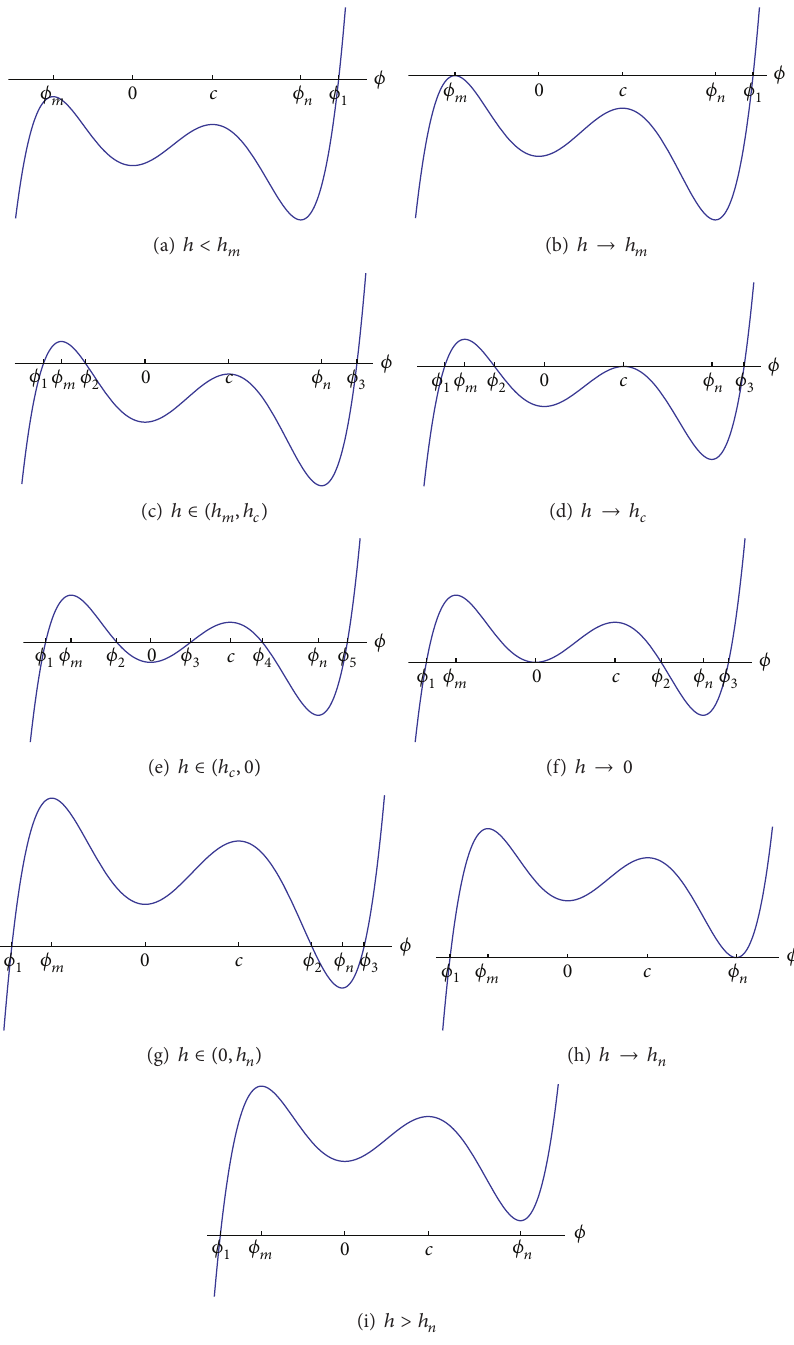
Figure 2: The graph of 𝐹(𝜙) as 𝑐 0 < (1/16)(16𝑐 − 75𝑐 2 )